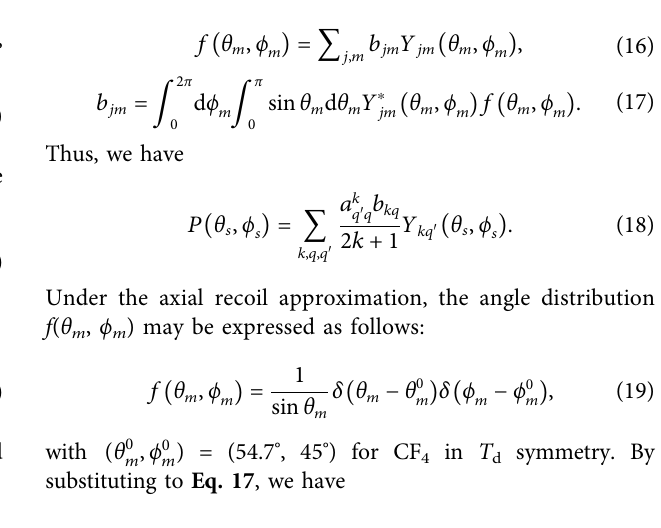
FIGURE 6 | Structure factors ofeigenorbitals, (A) | G A | 2 , (B) | G B | 2 , (C) | G C | 2 , and (D) the sum, Σ | G | 2 = | G A | 2 + | G B | 2 + | G C | 2 for HOMO, and (E) | G A | 2 , (F) | G B | 2 , (G) | G C | 2 and (H) Σ | G | 2 forHOMO-1.ThedotsrepresenttheEulerangles( β , γ )atwhichoneoftheC-Faxespointstothe Z direction.Thenumbersattachedtothedotsinpanels (D,H) represent the labels of the respective F atoms in Figure 2 . Note the difference in the scaling of the color bars in (A – H) .